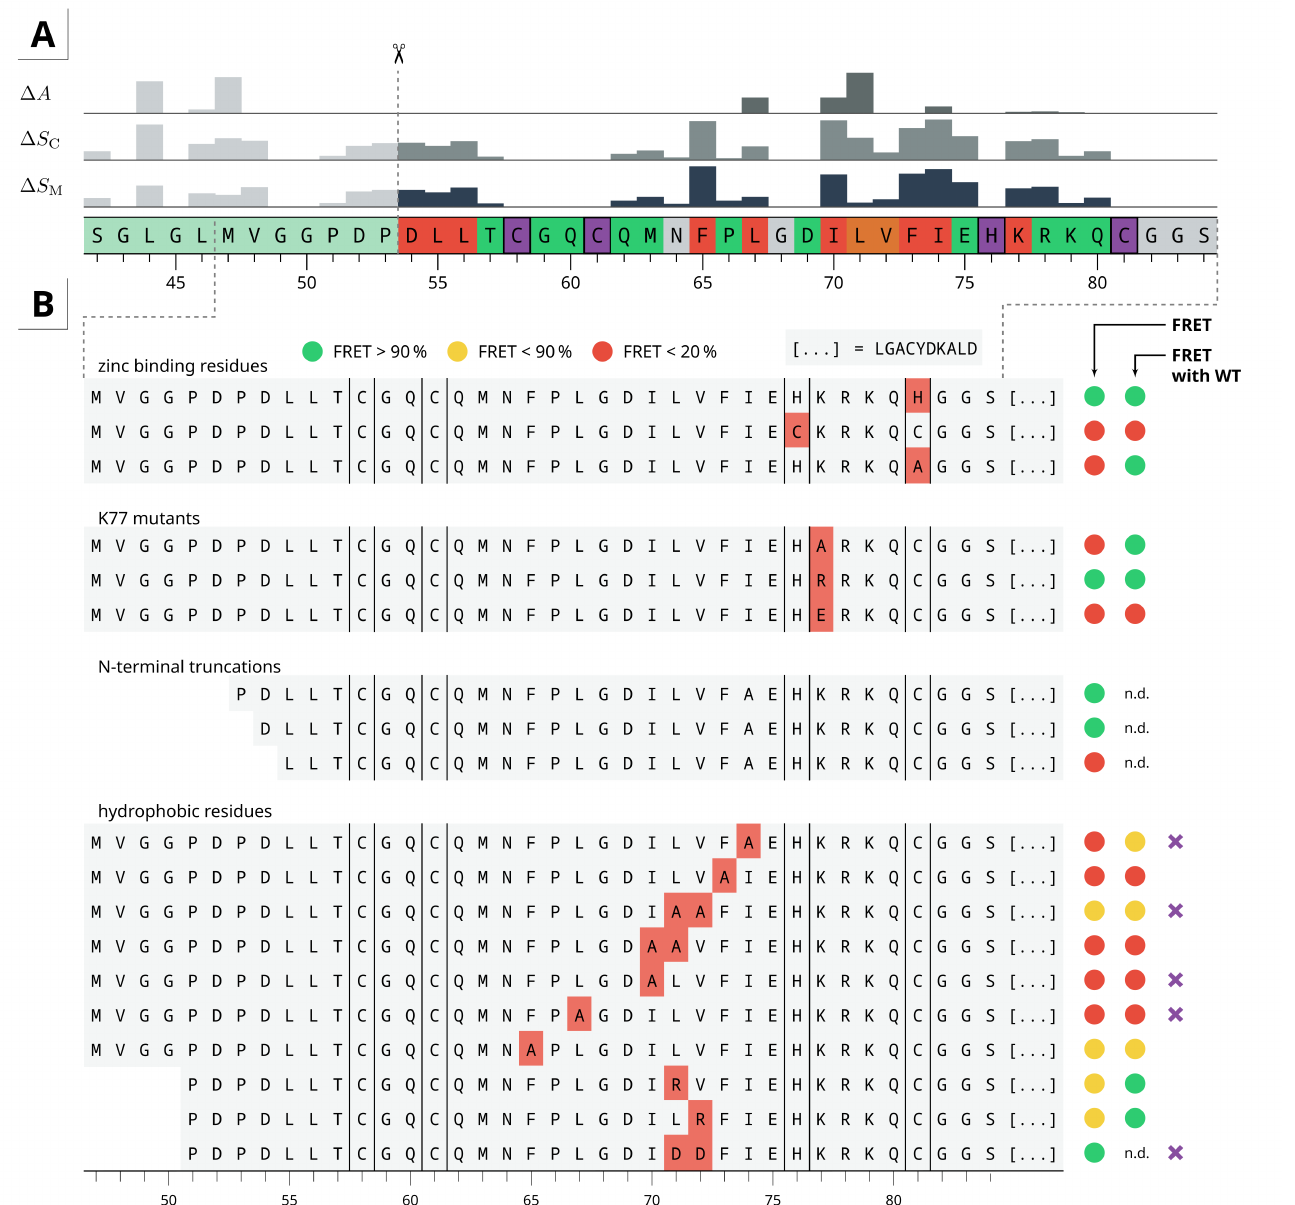
Figure 4. ( A ) (bottom) Summary of all experimental residue mutations colored by their effect on dimerization (red/orange: mutations prevent dimerization, green: mutation to alanine does not affect dimerization, purple: metal-binding residues). The bar charts (top) are the normalized changes in energy from in silico alanine scanning for monomer ( ∆ S M ) and complex ( ∆ S C ) stability, as well as affinity ( ∆ A ). Higher values mean a negative effect on both parameters. ( B ) Excerpt of key mutations and their dimerization potential to itself and wild-type. Purple crosses denote selected mutations for further protein-protein docking simulation with TIGER2h. (n.d.: not determined). More information can be found in Supplementary